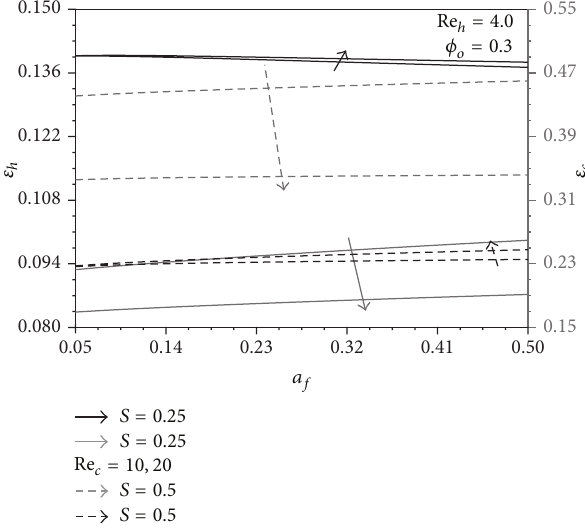
Figure 6: Effects of 𝑎 𝑓 and Re 𝑐 on 𝜀 ℎ and 𝜀 𝑐